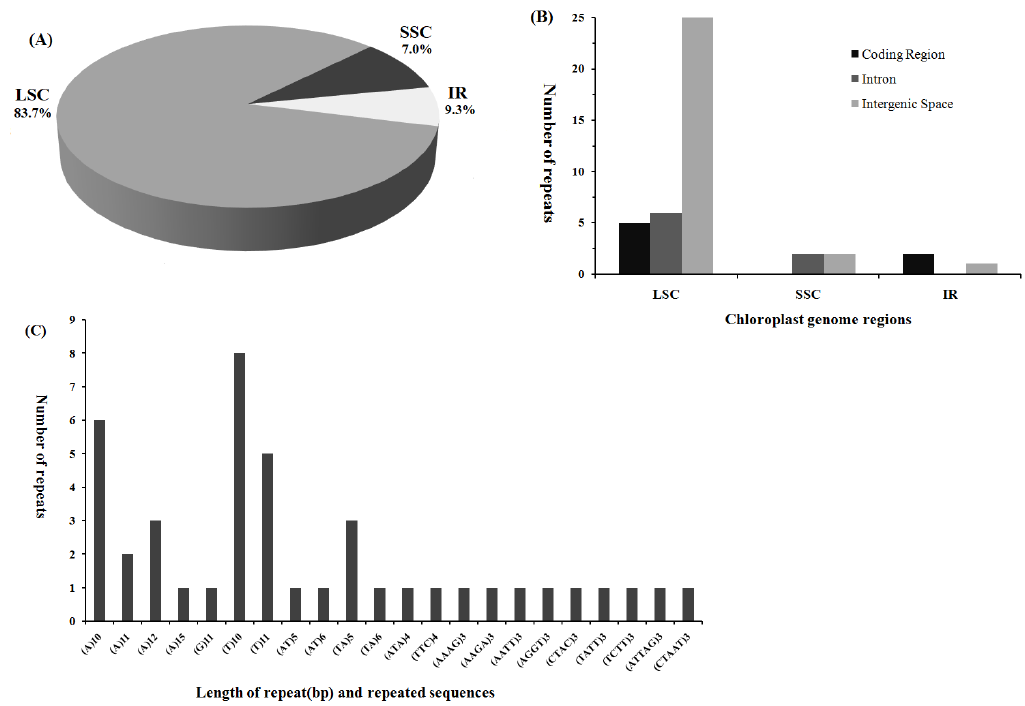
Figure 2. Distribution, type, and presence of simple sequence repeats (SSRs) in the chloroplast genome of D . oligodontus . ( A ) Presence of SSRs in the large single-copy (LSC), small single-copy (SSC), and inverted repeat (IR) regions. ( B ) Presence of SSRs in the protein-coding regions, introns, and intergenic spacers of LSC, SSC, and IR regions. ( C ) Presence of polymers in the chloroplast genome.